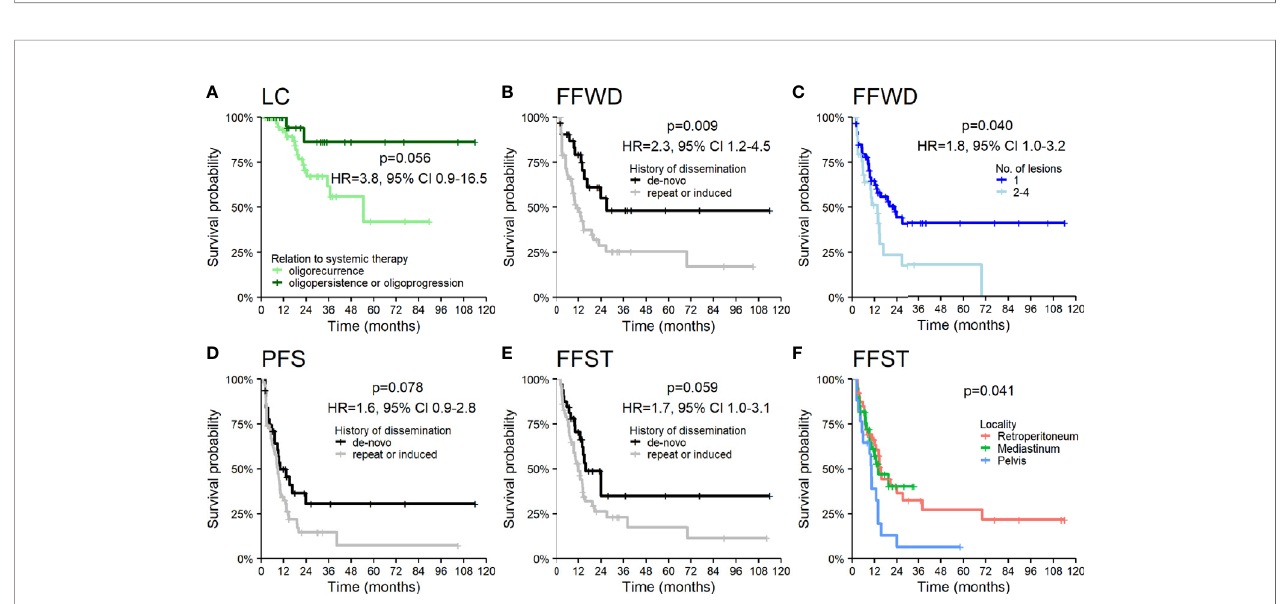
FIGURE 4 | Kaplan – Meier curves for (A) local control according to the relation of OD to systemic therapy, (B) freedom from widespread dissemination, (D) progression-free survival, (E) freedom from systematic treatment according to the history of dissemination, (C) freedom from widespread dissemination according to the number of lesions, and (F) freedom from systematic treatment according to the locality of lesions. Panels include corresponding hazard ratios ( HR) with 95% con fi dence intervals